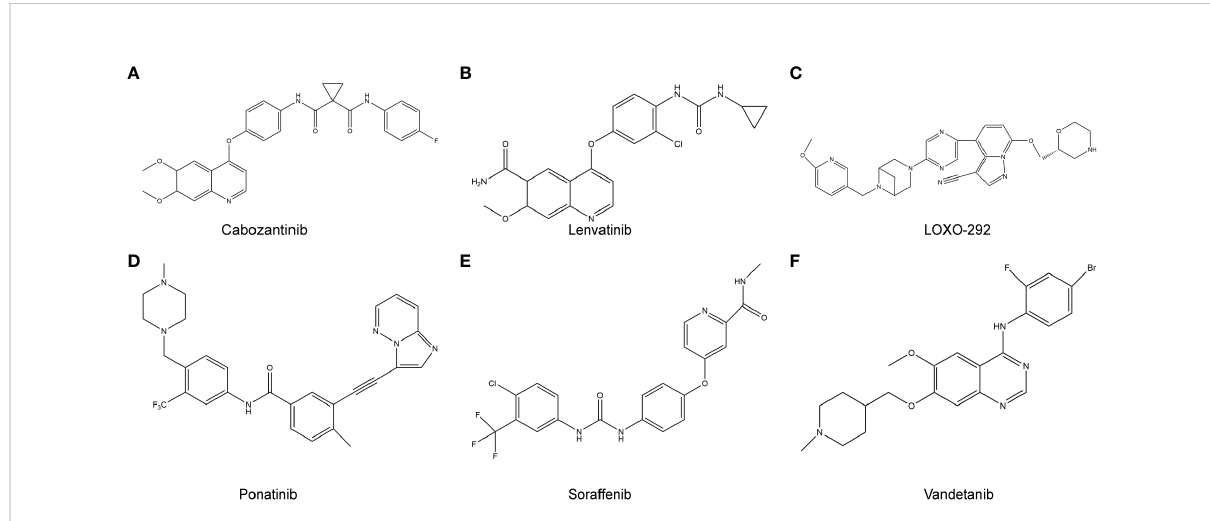
FIGURE 2 RET target-related chemotherapy drugs. (A) , cabozantinib; (B) , Lenvatinib; (C) , LOXO-292; (D) , Ponatinib; (E) , Sorafenib; (F) ,